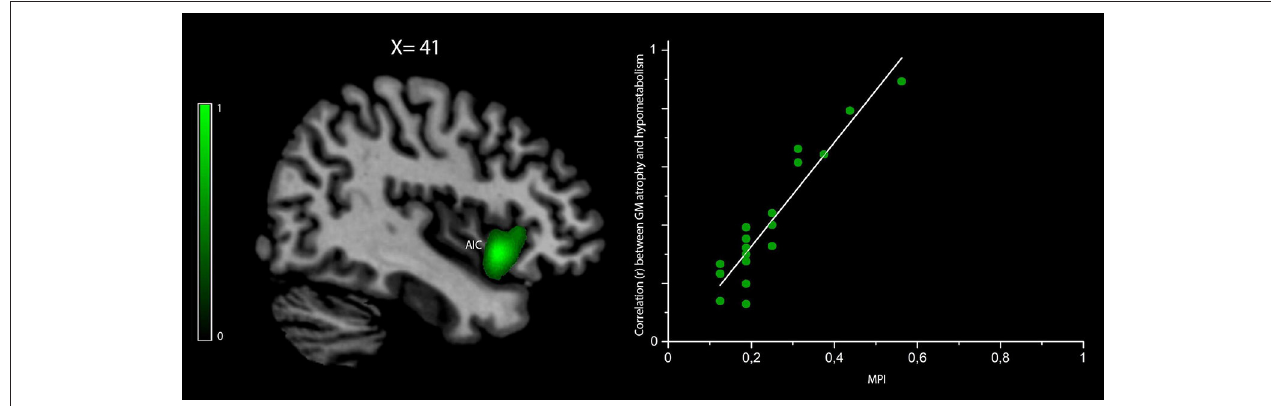
FIGURE 3 | Voxelwise correlation between frailty, density loss, and hypometabolism in behavioral variant frontotemporal dementia (bvFTD) patients. Correlation between the MPI scores and voxels where gray matter (GM) density loss and hypometabolism were linearly correlated (i.e., “co-occurred”) is shown in green (color spectrum represents r -values). The map is reported in accordance with radiological convention (i.e., left is right). MNI coordinate is on top of the panel . AIC, anterior insular cortex; MPI, Multidimensional Prognostic Index; MNI, Montreal Neurological